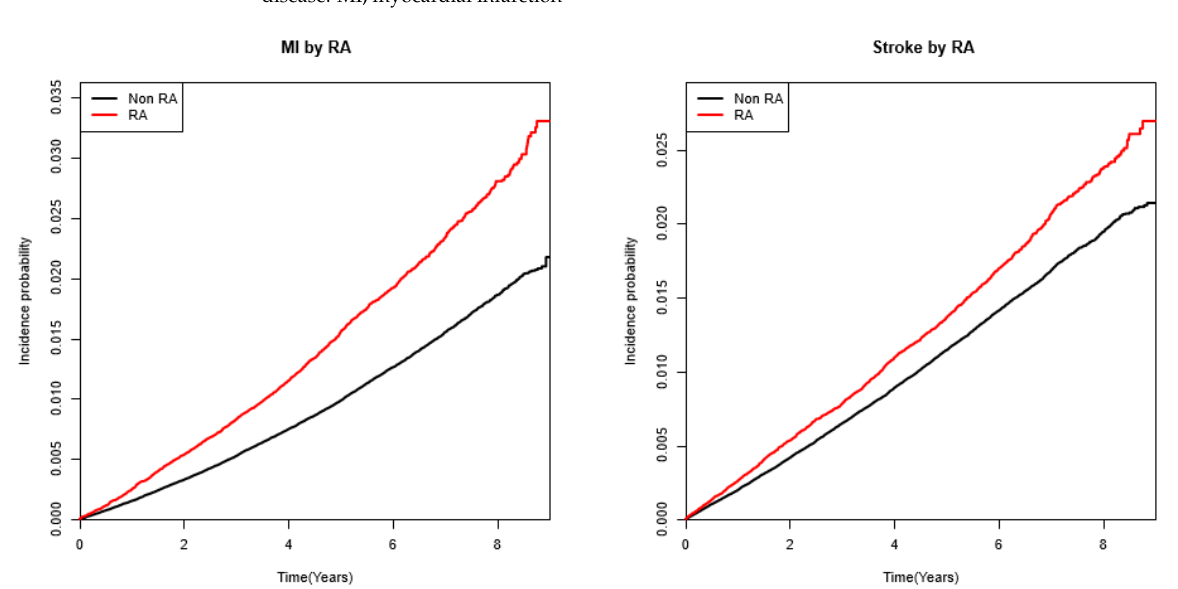
Figure 2. Cumulative incidence curve of CV events in patients with RA and non-RA control indi- viduals.